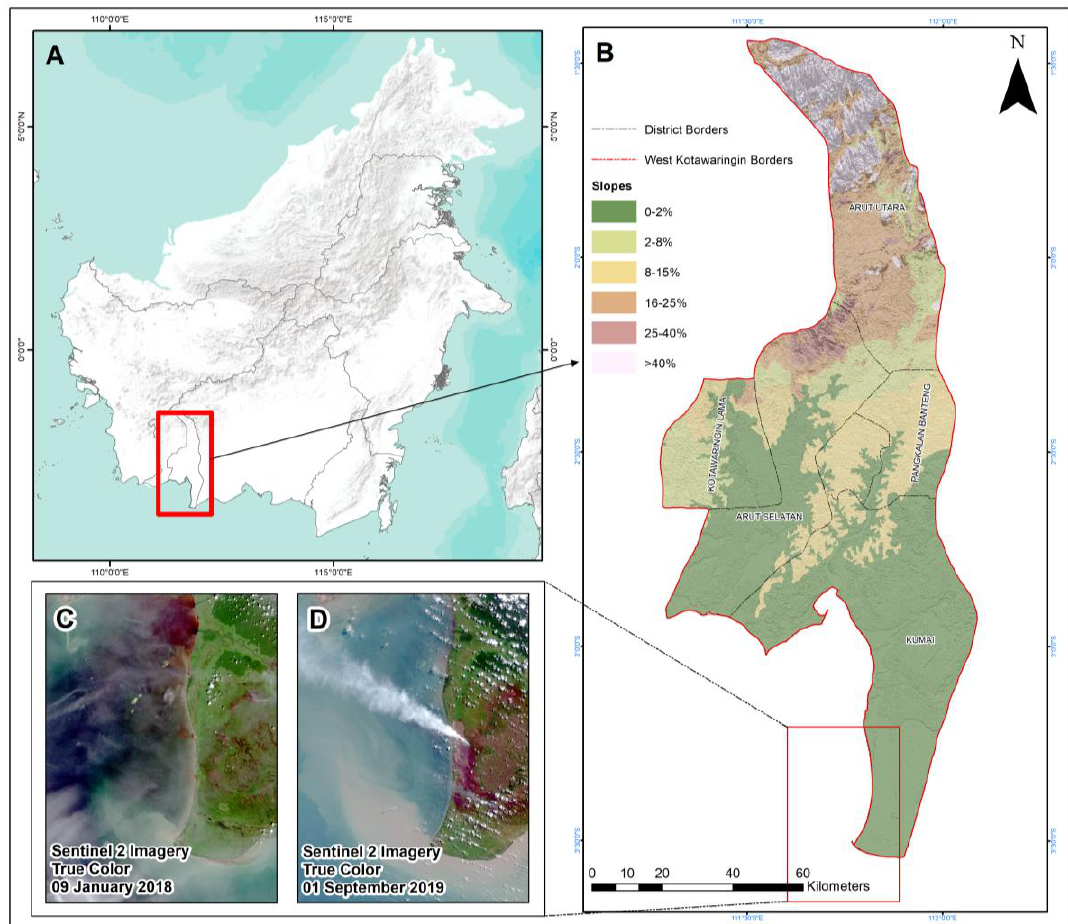
Figure 1. ( A ) Overview map, ( B ) topographical characteristics of the research area, ( C ) pre-fire event, ( D ) post-fire event. ( D ) post-fire